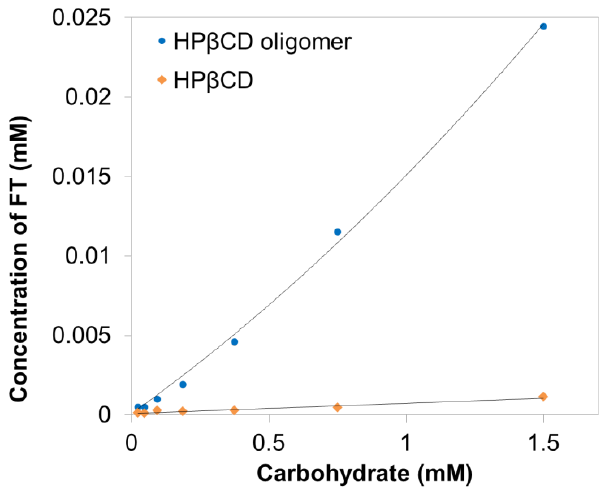
Figure 5 . Phase solubility diagrams of FT as a function of HP-β-CD ( ♦ ) and HP-β-CD-ol (●) in water at 25 °C. Table 1. Binding constants and solubility efficiencies of FT complexes with HP-β-CD-ol.